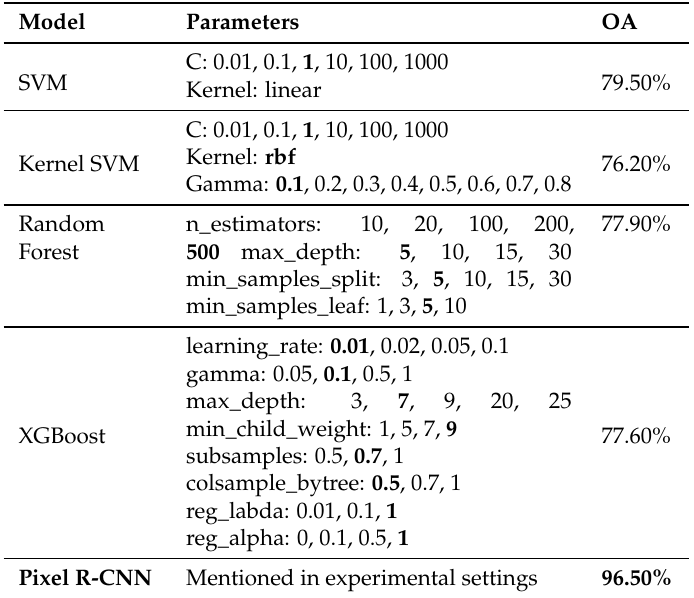
Table 6. Comparison of Pixel R-CNN with non-deep learning classifiers.